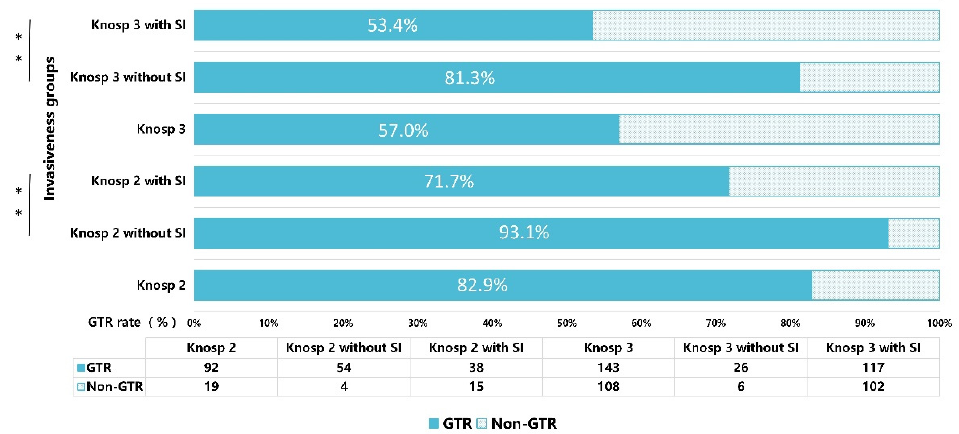
Figure 6. Kaplan–Meier survival curves of Knosp grade 2–3 with or without surgical invasiveness. ( A ) Kaplan–Meier survival curves of Knosp grade 2 with or without surgical invasiveness. ( B ) Kaplan–Meier survival curves of Knosp grade 3 with or without surgical invasiveness. KM: Kaplan– Meier; HR, Hazard Ratio. 3.5. Invasiveness Classification 2 Invasiveness Classification 2, which depends on a combination of radiographic and surgical characteristics, is presented in Table 1. As shown in Table 3, the higher the grade of invasiveness, the lower the GTR rate, and the more likely recurrence/progression is. GTR and recurrence/progression rates of invasive (grade 3–4) and non-invasive (grade 0– 1) PAs in Invasiveness Classification 2 were 62.5% and 43.1%, and 46.2% and 67.7%, respectively. RPFS of PAs of Invasiveness Classification 2 are presented as KM curves (Figure 7). RPFS values of invasive (grade 3–4) PAs were shortest, followed by grade 2 and non-invasive (grade 0–1) PAs. Moreover, KM curves for two subgroups in grade 2 revealed that poor prognosis of intermediate grade was not well predicted by radiological and surgical indicators of invasiveness alone.